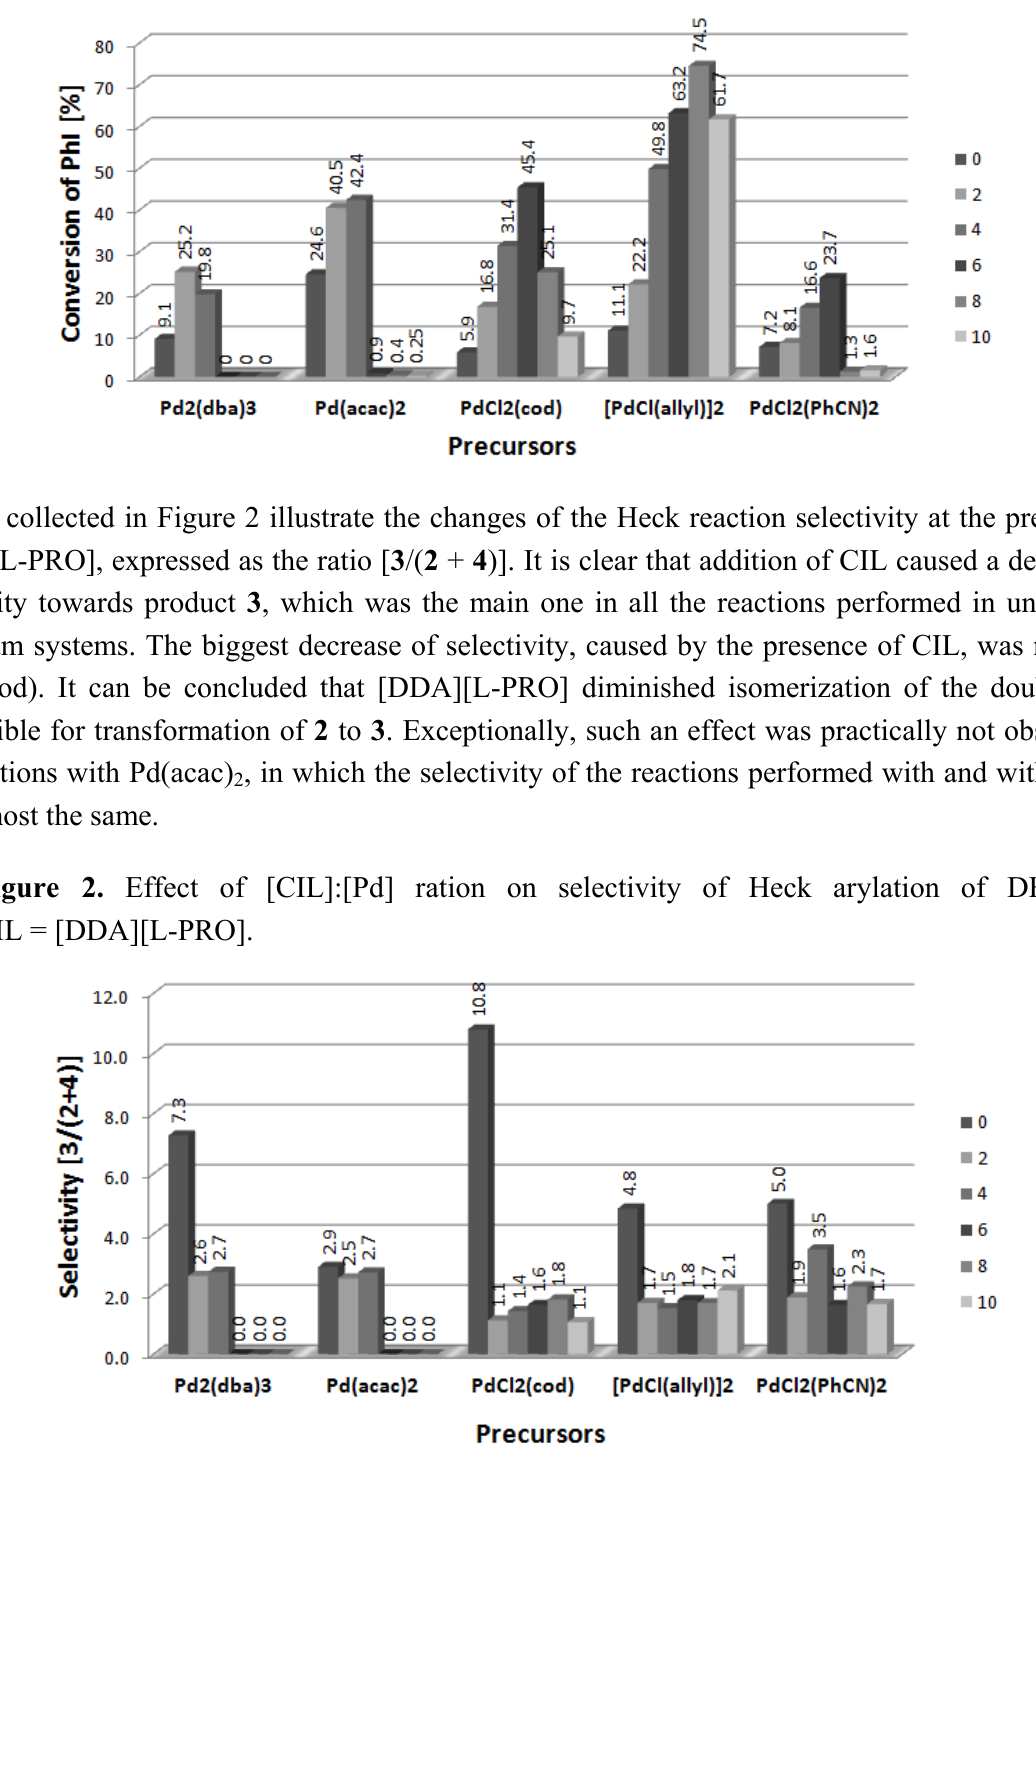
Figure 1. Effect of [CIL]:[Pd] ratio on conversion of PhI in Heck arylation of DHF. CIL = [DDA][L-PRO].